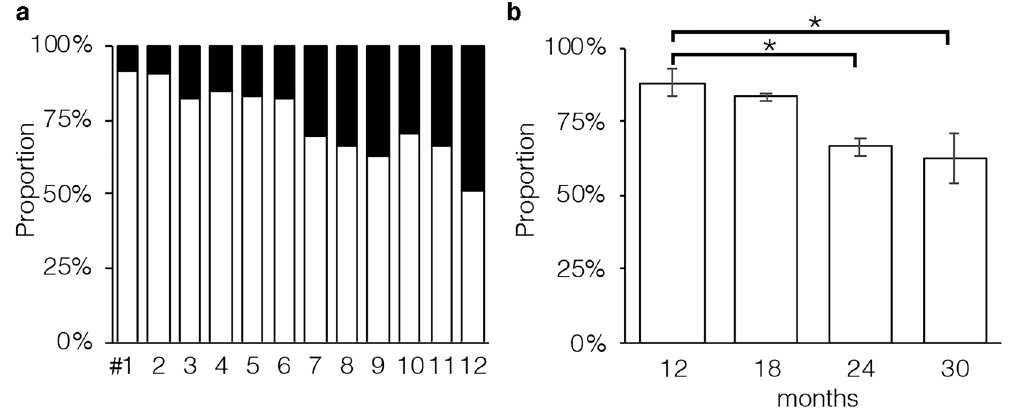
Figure 3. Proportions of tubule areas belonging to two types marked with corresponding colors in individual mice ( a ) and in groups of mice (12, 18, 24, and 30 months) ( b ). In ( b ), each value represents the mean ± SD of three samples. *Significantly different (P = 0.02).